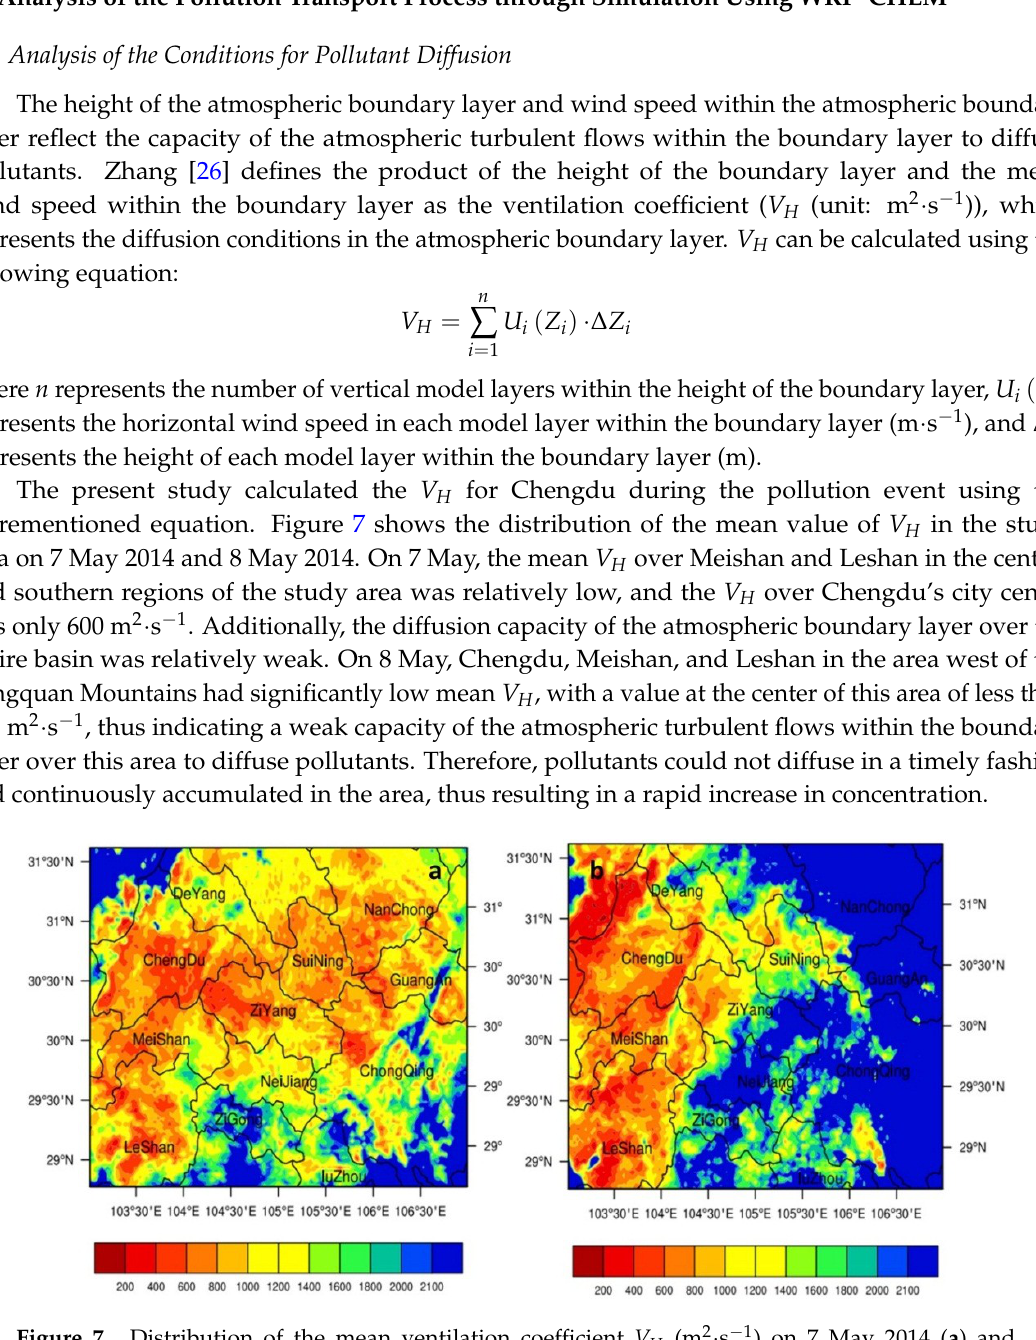
Figure 7. Distribution of the mean ventilation coefficient V H (m 2 · s − 1 ) on 7 May 2014 ( a ) and 8 May 2014 ( b